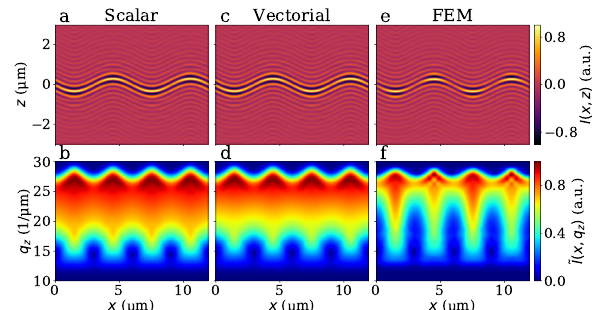
Figure 1: O ff set reduced interference signals obtained from a sinusoidal surface profile with L x = 6 µ m and max- imum surface slope of 18 ◦ simulated with the scalar model (a), vectorial model (c) and FEM (e). The bottom row dis- plays the Fourier transform of the interference intensities shown in the upper row with respect to the optical